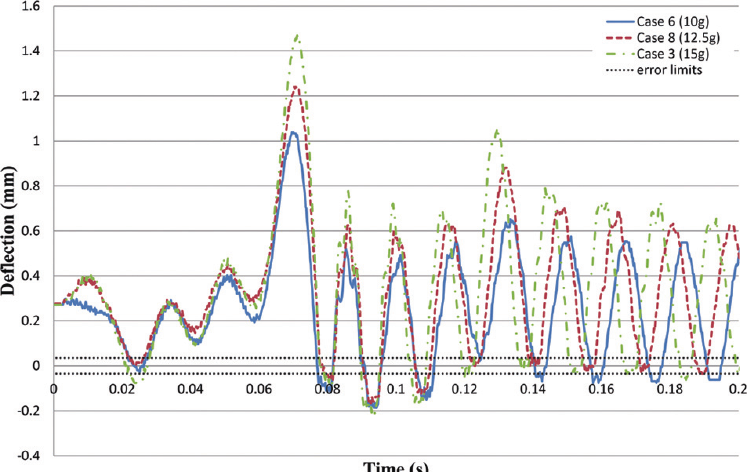
Fig. 5. Response with changing pulse amplitude.